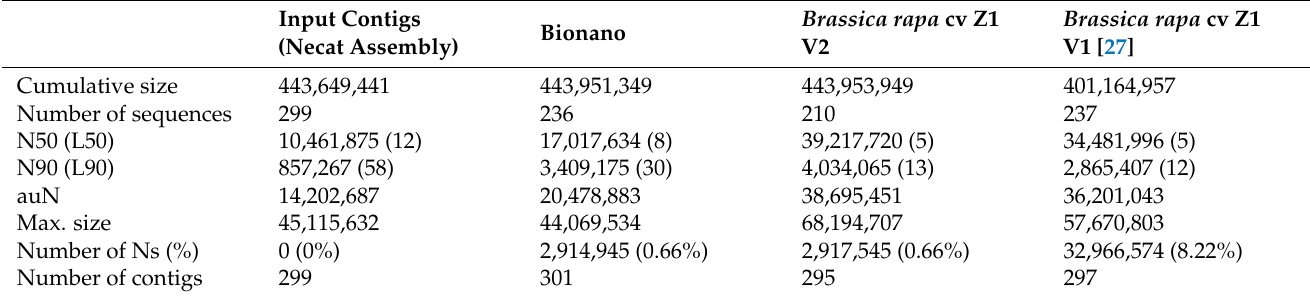
Table 3. Metrics of the final version of Brassica rapa cv Z1 Version